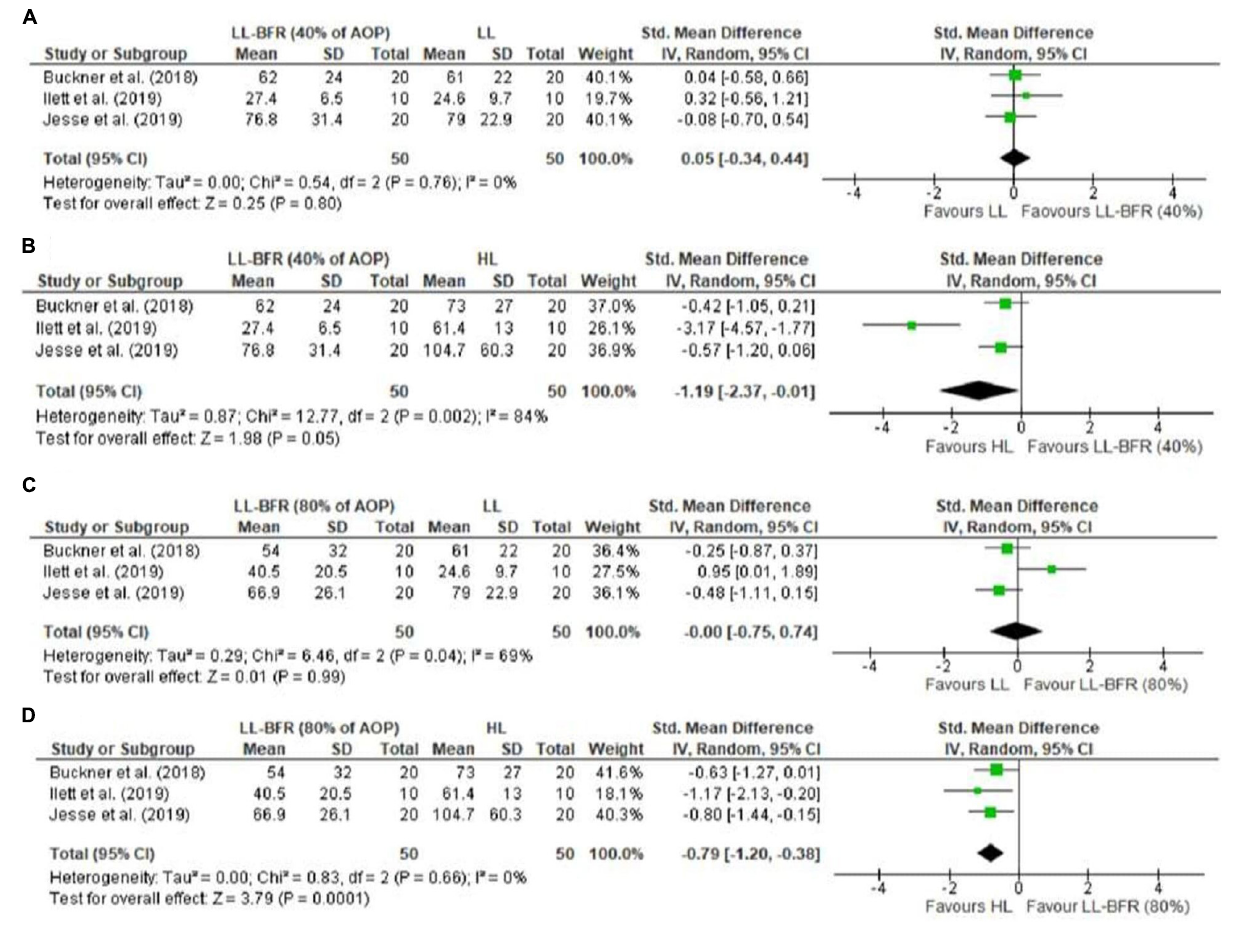
FIGURE 5 | Forest plot illustrating the combined effects for myoelectric activity of: (A) LL-RE with BFR pressure of 40% AOP vs. LL-RE (NO-BFR); (B) LL-RE with BFR pressure of 40% AOP vs. HL-RE (NO-BFR); (C) LL-RE with BFR pressure of 80% AOP vs. LL-RE (NO-BFR); (D) LL-RE with BFR pressure of 80% AOP vs. HL-RE (NO-BFR). 95%CI: confidence interval; AOP: arterial occlusion pressure; HL: high load; LL-BFR: low load + blood flow restriction; LL: low load; SD: standard